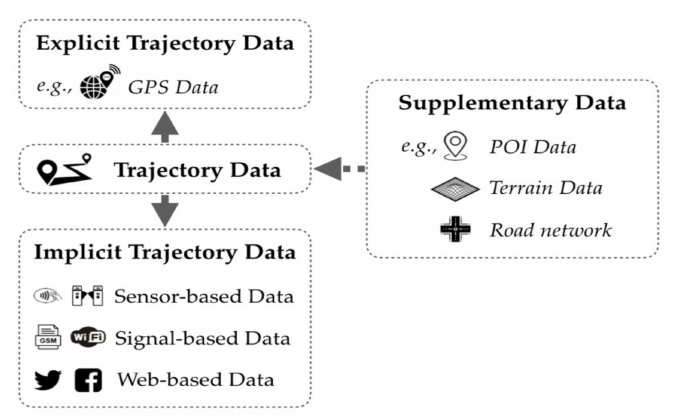
Figure 2. Trajectory data categories